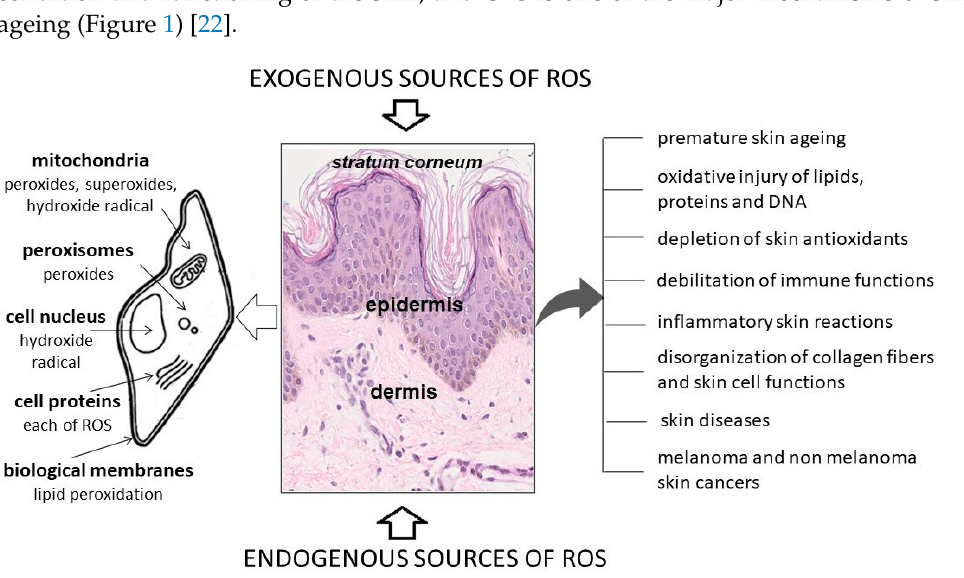
Figure 1. Potential cellular components attacked by reactive oxygen species (ROS) and the effect of oxidative stress on the skin (own work based on [6,7,17]; photo: Department of Clinical and Experimental Pathology, Collegium Medicum, Jan Kochanowski University).